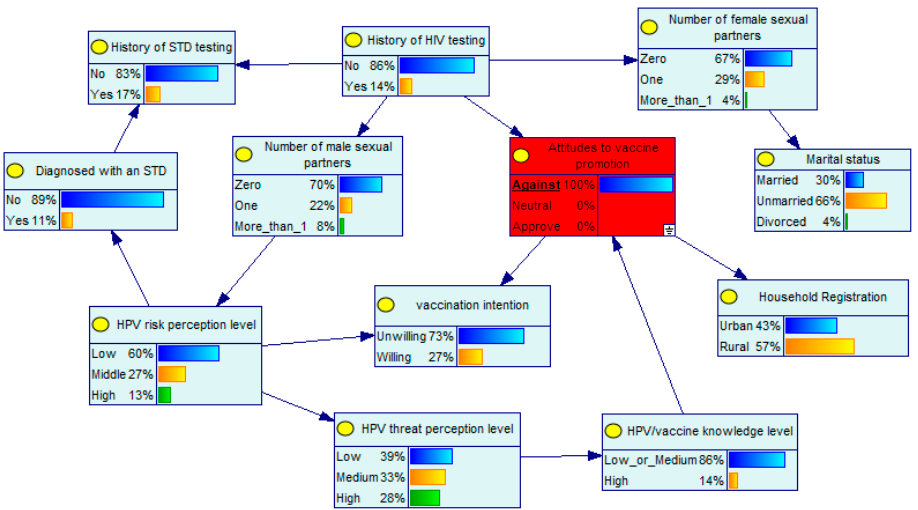
Figure 4. Bayesian network with known node probabilities III.